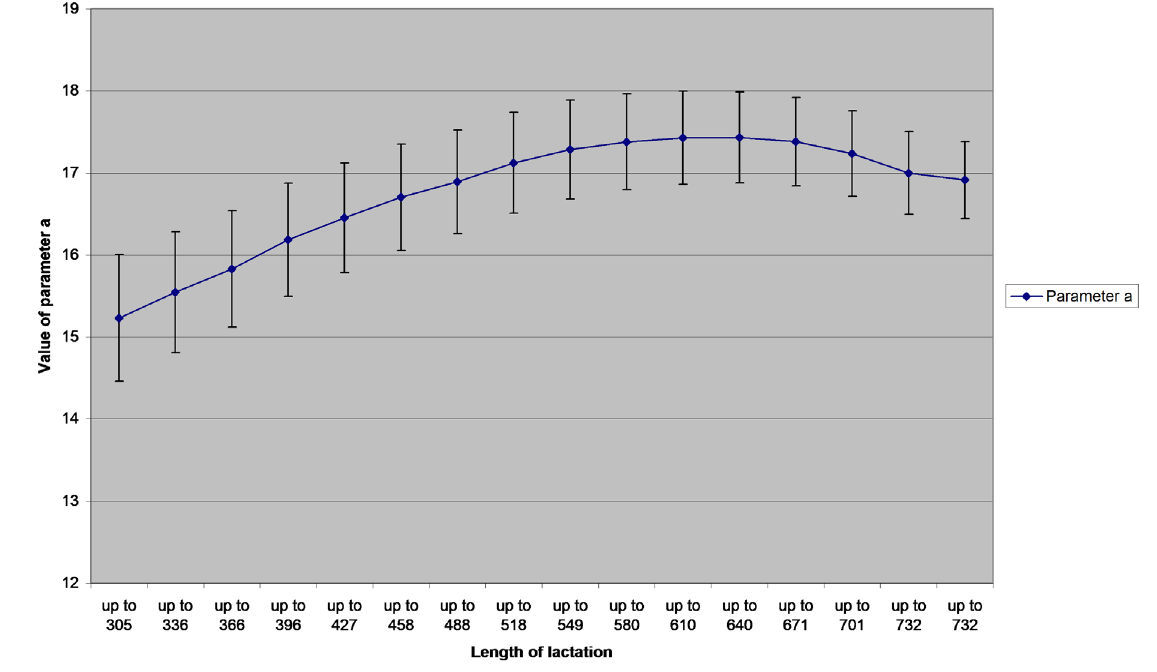
Figure 1. Mean values and their standard errors (+/– 2.96 standard error) of the assessed parameter a of Wood’s model for different lengths of lactation (in